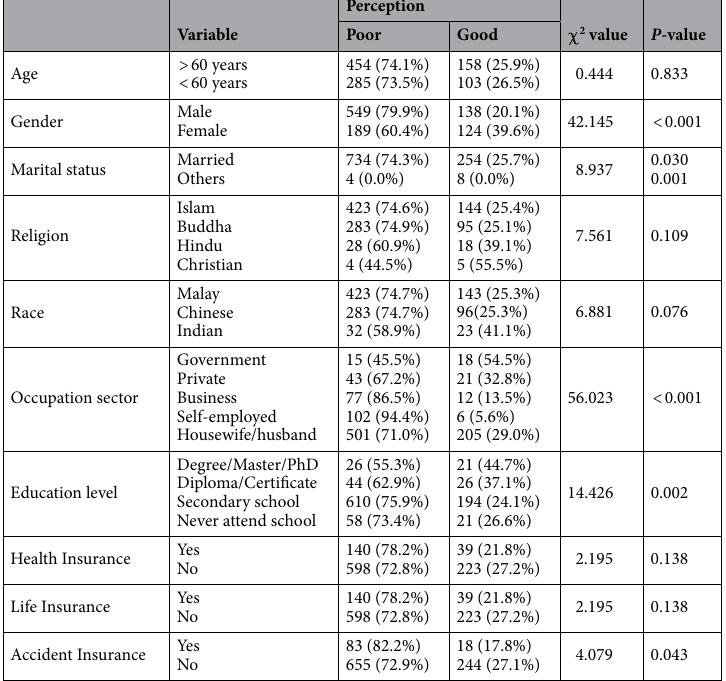
χ 2 value P valuePoor